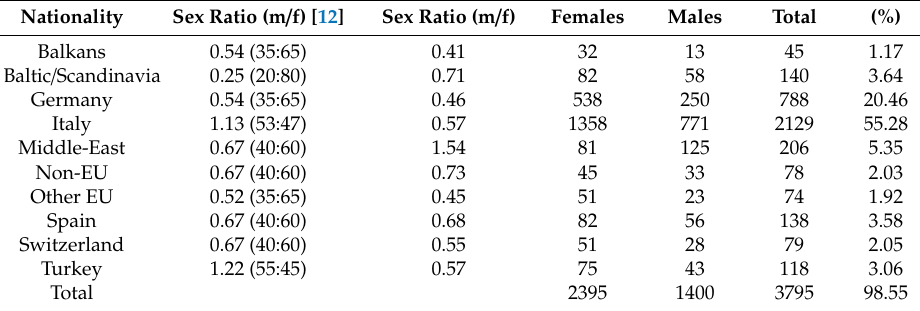
Table 1. Distribution of the sample across nationality and sex.